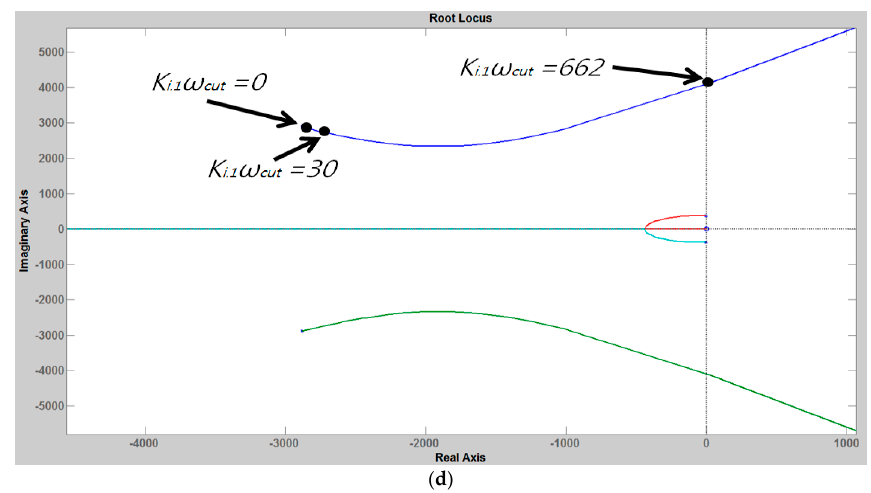
Figure 4. Block diagram and root locus of the inner current control loop: ( a ) outer voltage loop block diagram; ( b ) root locus for K p variations under K i. 1 ∙ω 1 . cut = 0; ( c ) root locus for K i. 1 ∙ω 1 . cut variation under K p = 0; ( d ) root locus for K i. 1 ∙ω 1 . cut variations under K p = 0.0577.